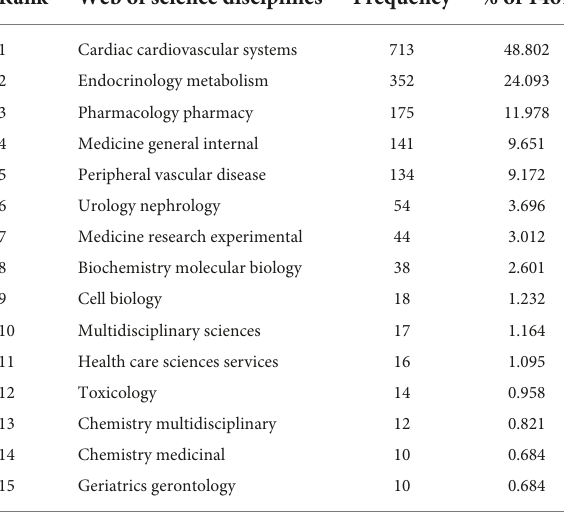
TABLE 2 Top 15 disciplines in the field of EMPA for HF in